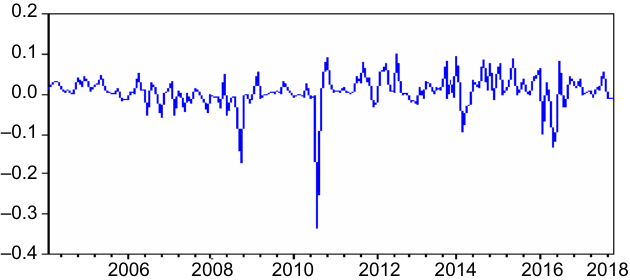
Figure 1. Dynamics of